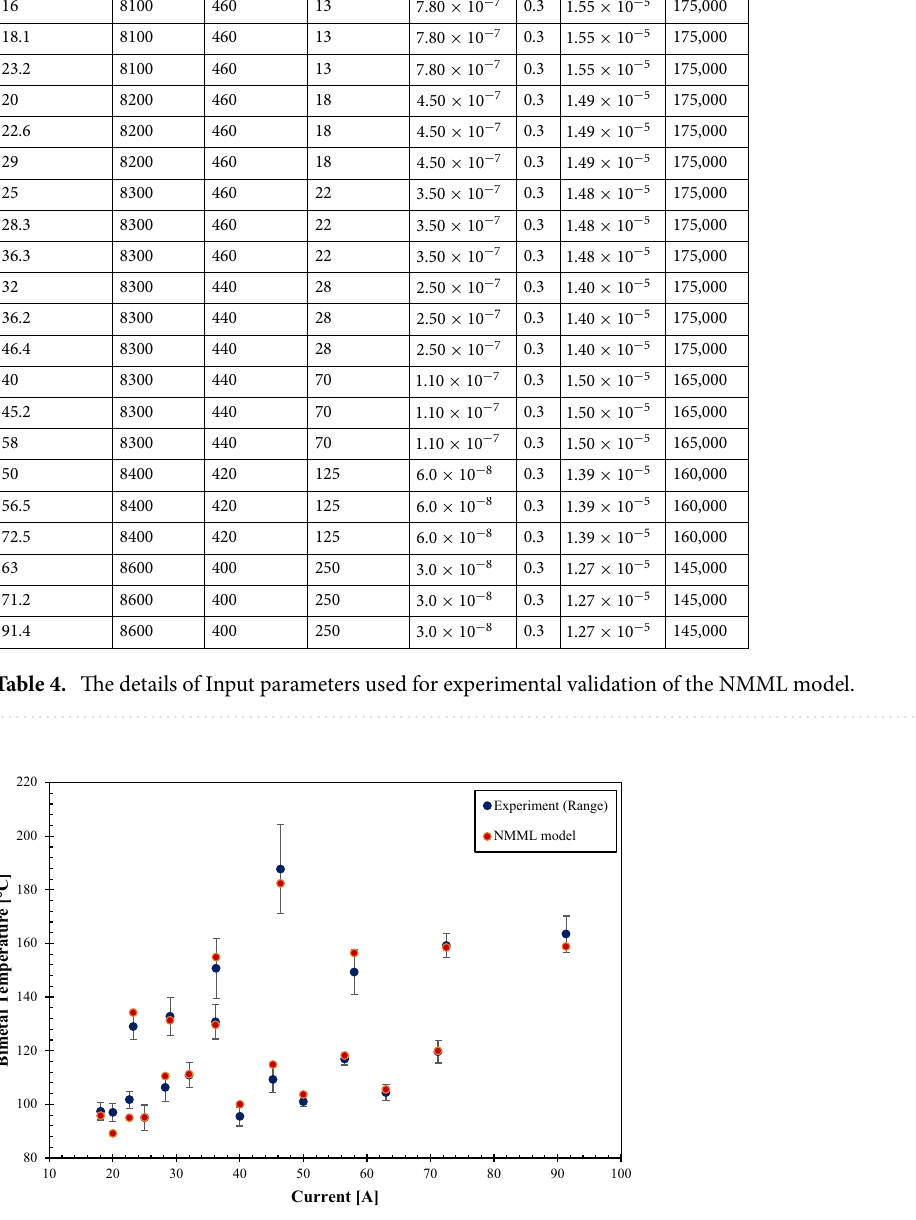
Figure 5. Validating the NMML model with experimental